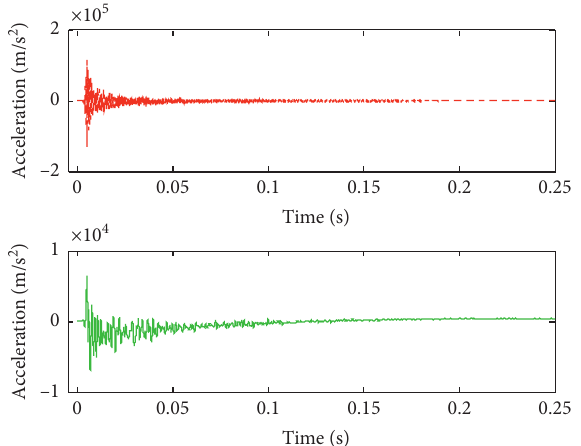
Figure 8: Signal comparison before and after filtering.